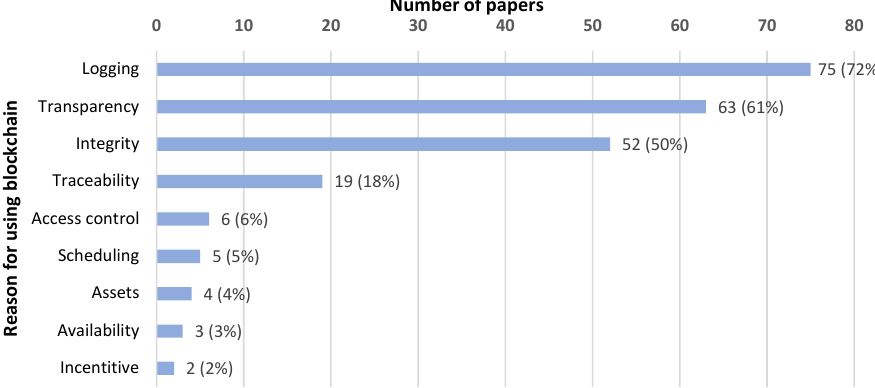
Figure 13. Reasons for using blockchain exploited in the papers included in our scoping review.